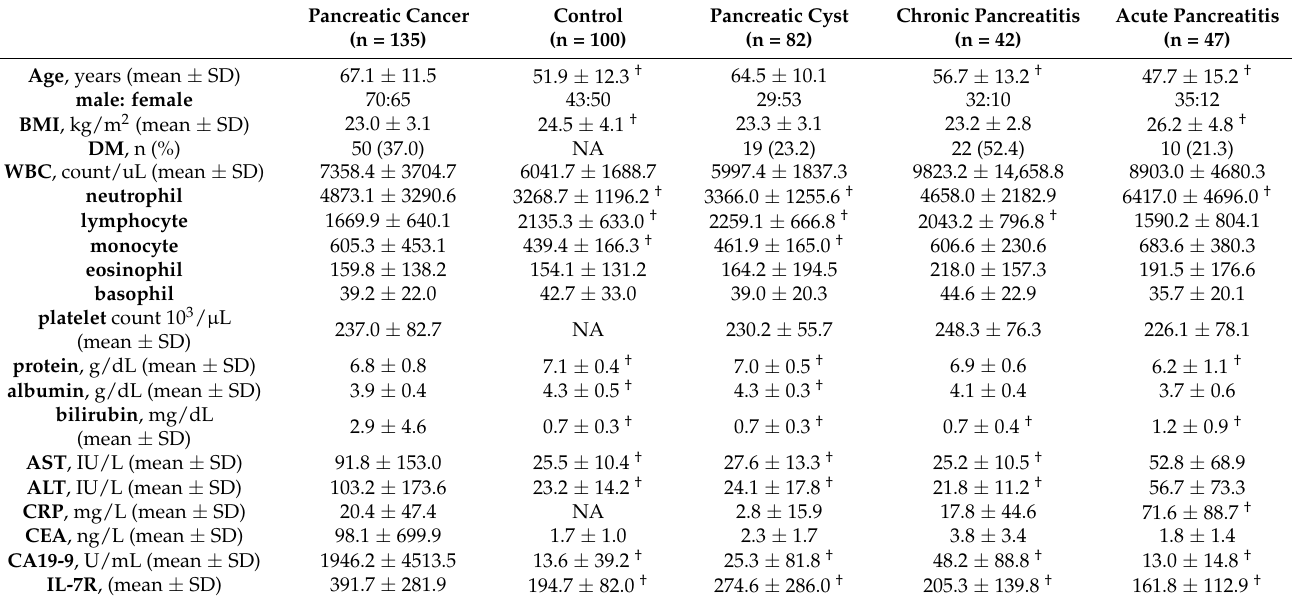
Table 1. Characteristics of the study population.